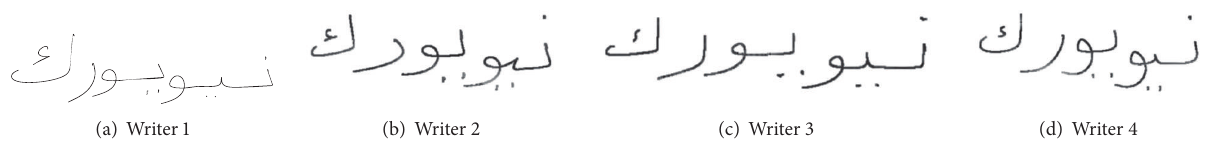
(cid:4)#I(cid:24)(cid:8)I(cid:23)(cid:8)(cid:6) (cid:24) Figure 6: The word (New York), synthesized by the average letter shapes 𝑥 of different